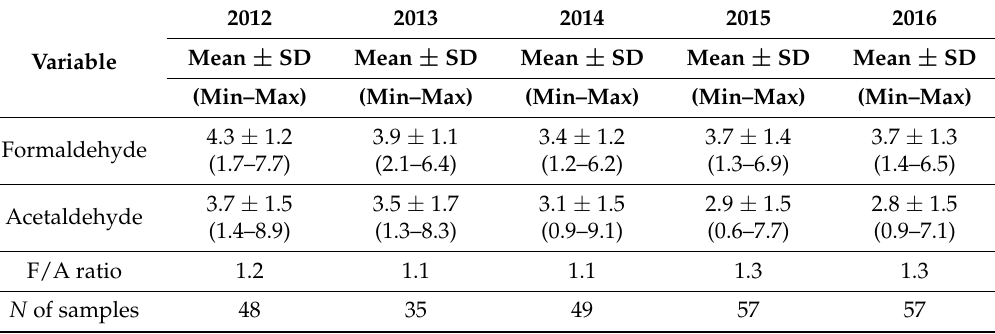
Table 2. Mean formaldehyde and acetaldehyde concentrations (ppbv), together with F/A ratios, in the Metropolitan Area of S ã o Paulo (MASP) between 2012 and